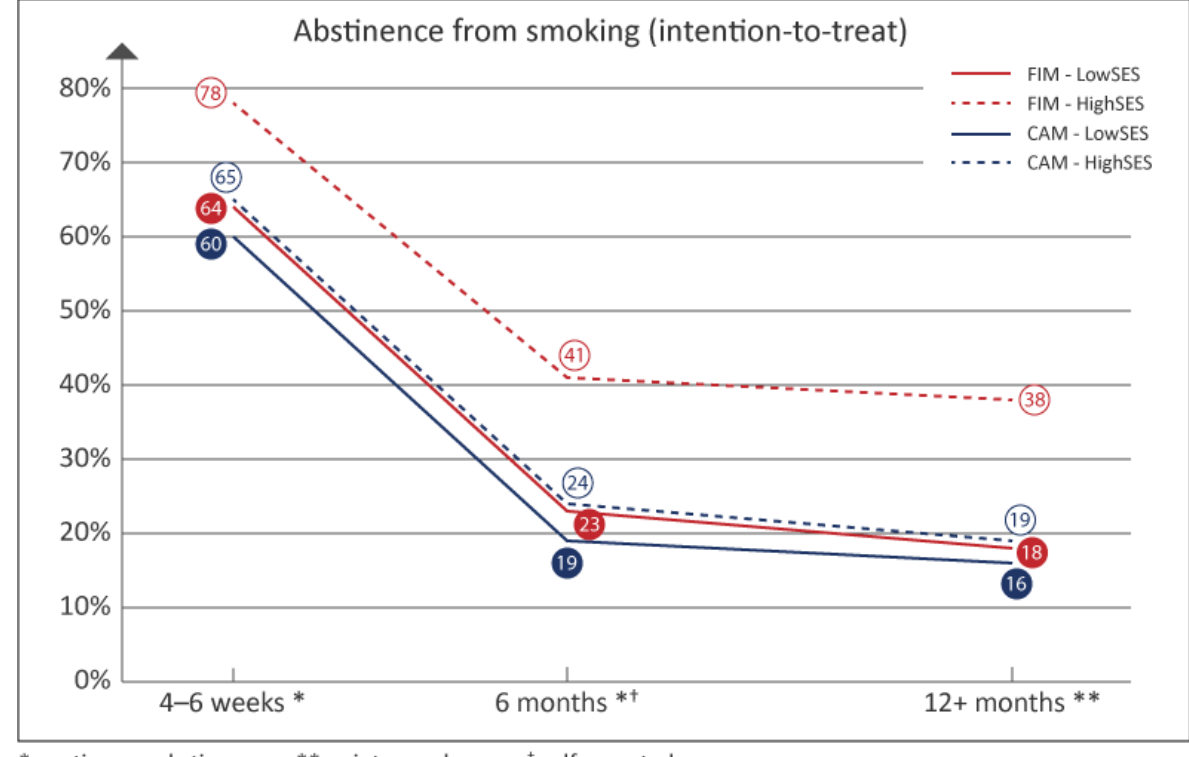
Figure 2. Abstinence rates from smoking in the “Richer without smoking” study, based on the intention-to-treat principle; Denmark, 2018. Validated abstinence rates at the end of the intervention (4–6 weeks), after 12+ months, and self-reported abstinence rates after 6 months. FIM: financial incentive municipality, CAM: campaign municipality, SES: socioeconomic status.